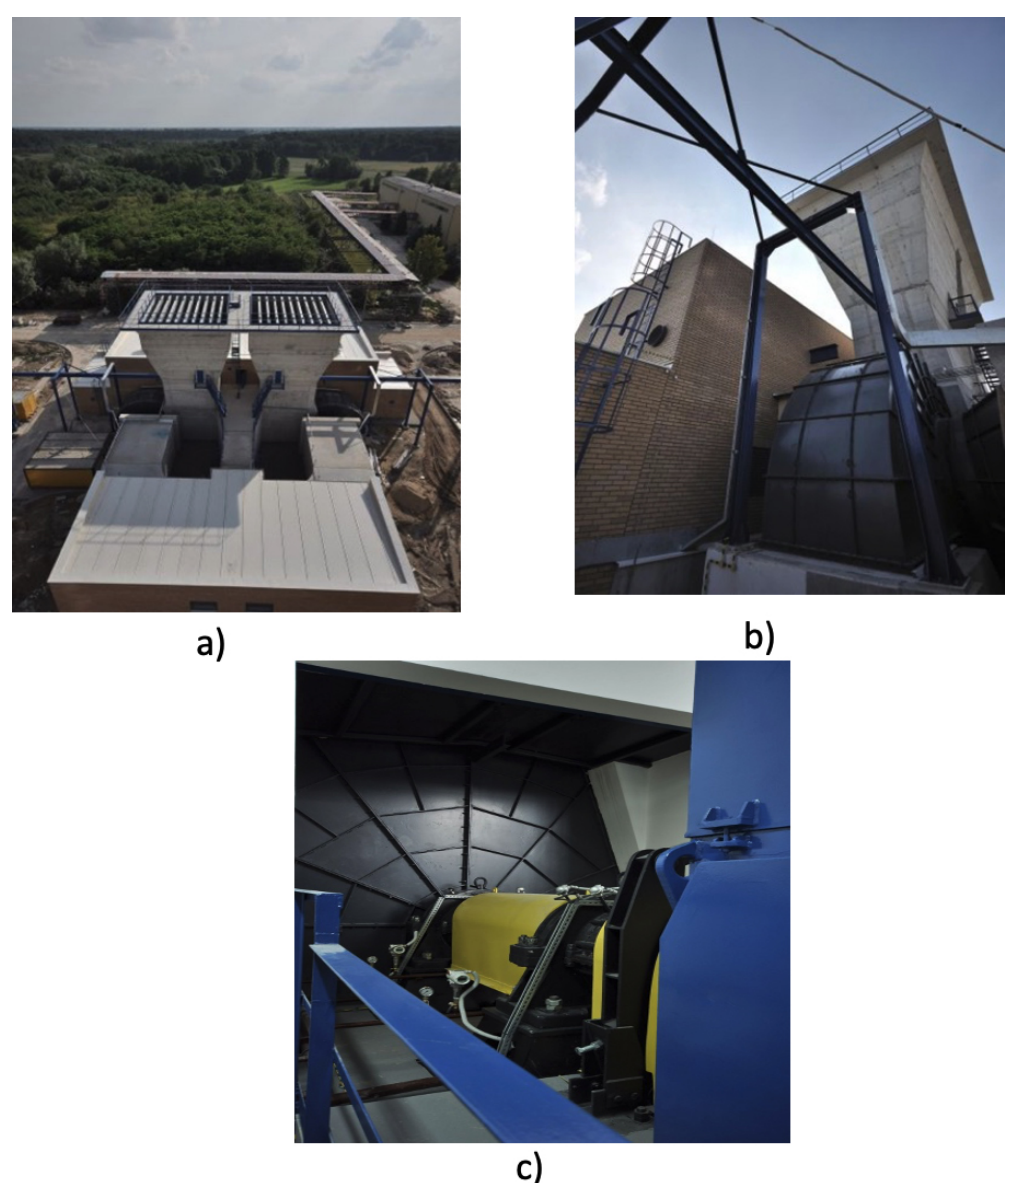
Figure 5. Photographs of the fan station with the diffuser in the Bogdanka coal mine built by Stalkowent sp. z o.o: (a) a fan station with a diffuser – view from above; (b) a photograph of the channel lock, the main valve, and the dif- fuser; (c) the main valve and the fan. Source: promotional materials of Stalkowent sp. z o.o.: